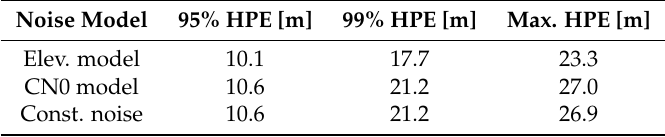
Table 1. Positioning results of the tightly coupled UKF using different noise